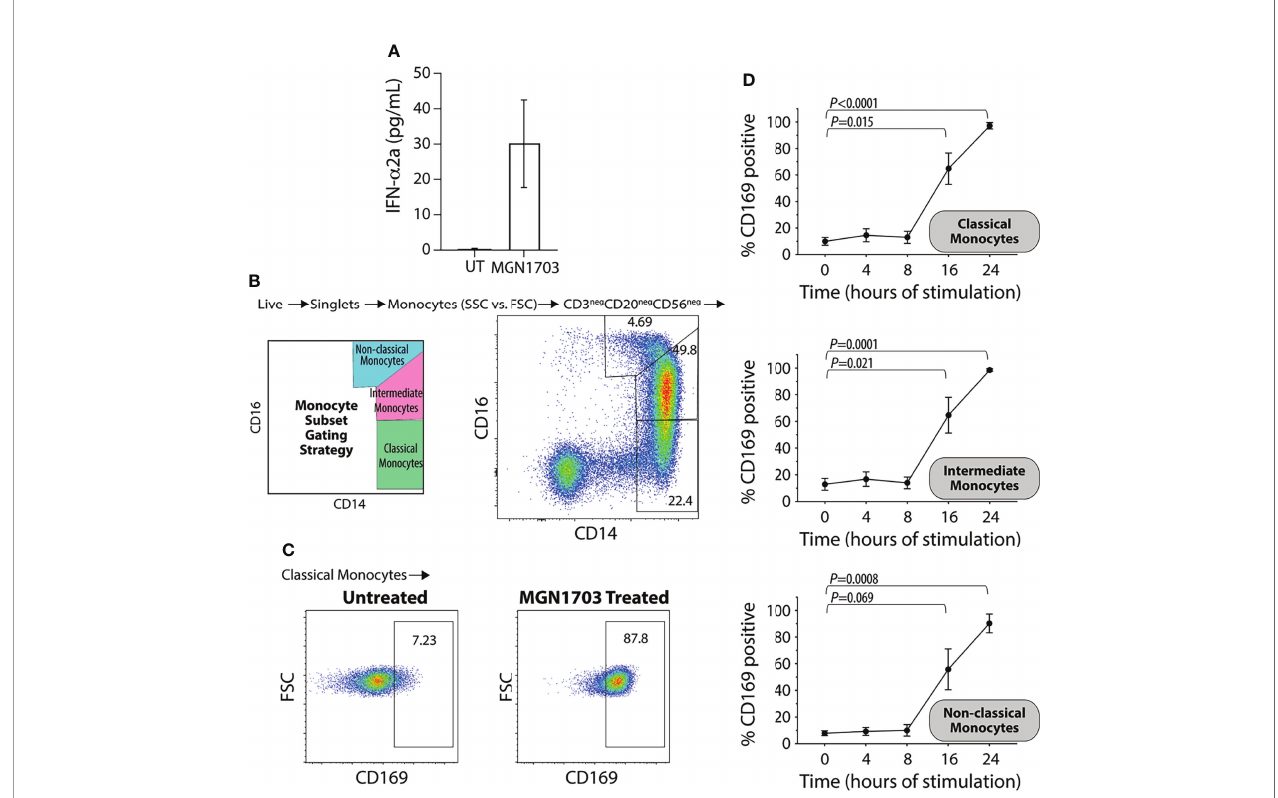
FIGURE 1 | Upregulation of CD169 on human monocytes following ex vivo TLR9 agonist stimulation. (A) Levels of IFN- a in supernatants from human PBMCs stimulated with TLR9 agonist (MGN1703 3 m M) for 24 hrs. Bar-graph depicts average IFN- a levels obtained from stimulation of fi ve individual donors (+/- SEM). UT=untreated. (B) Flow plot demonstrating monocyte subset gating strategy with representative data. Classical monocytes CD14+/CD16 int , Intermediate monocytes CD14+/CD16+ and the non-classical monocytes CD14 int /CD16+. (C) Flow plots depicting the impact of MGN1703 on CD169 expression on classical monocytes after 24 hrs of stimulation for a representative donor (D) Time-dependent upregulation of CD169 on monocytes. Human PBMCs were stimulated with TLR9 agonist (MGN1703 at 3 m M) for 4, 8, 16 or 24 hrs. Levels of CD169 on monocyte subsets were measured using fl ow cytometry. Depicted in the graph is the average (+/- SEM) from fi ve individual donors. Levels of CD169 on each monocyte subset were analyzed by paired ANOVA and Dunnett ’ s multiple comparison tests were performed for each time-point compared to